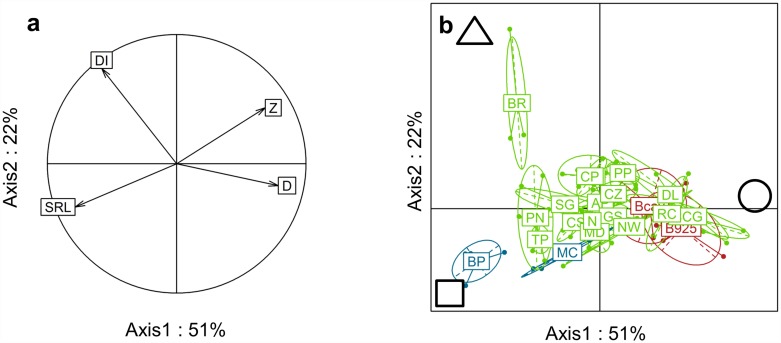
Principal component analysis on four soil-resource exploitation traits and 21 species (n = 4 replicates for all species except BD (n = 3)).a Correlation circle between traits; b Representation of weed species (in blue), banana cultivars (in red) and cover plant species (in green) on the first two axes (see Table 2 for the species names). The soil-resource exploitation traits are: SRL for specific root length, DI for total root-impact density, Z for median root exploration zone and D for root diameter. The symbols represent contrasted plant strategies, with a triangle for species with a high DI (total root-impact density), a square for species with a high SRL (specific root length) and a circle for species with high Z (median root exploration zone) and D (root diameter).